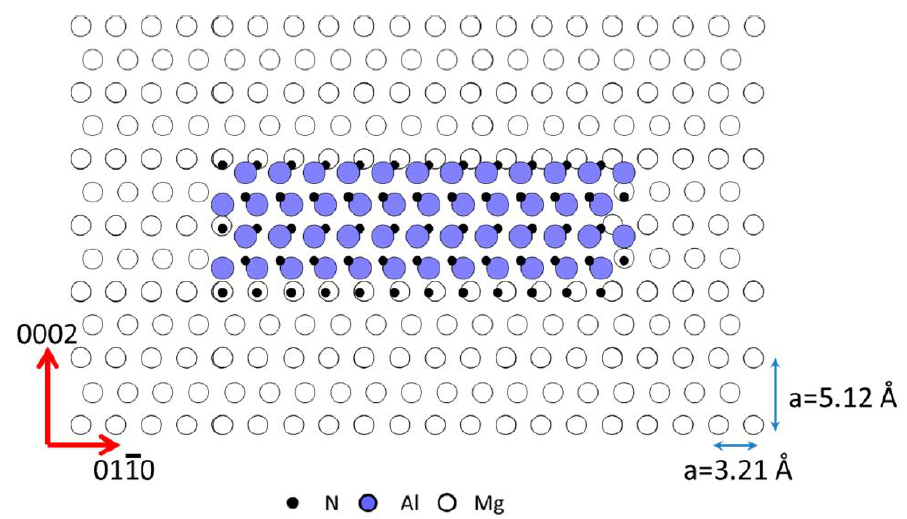
Figure 5. Crystallography of an AlN particle within a magnesium